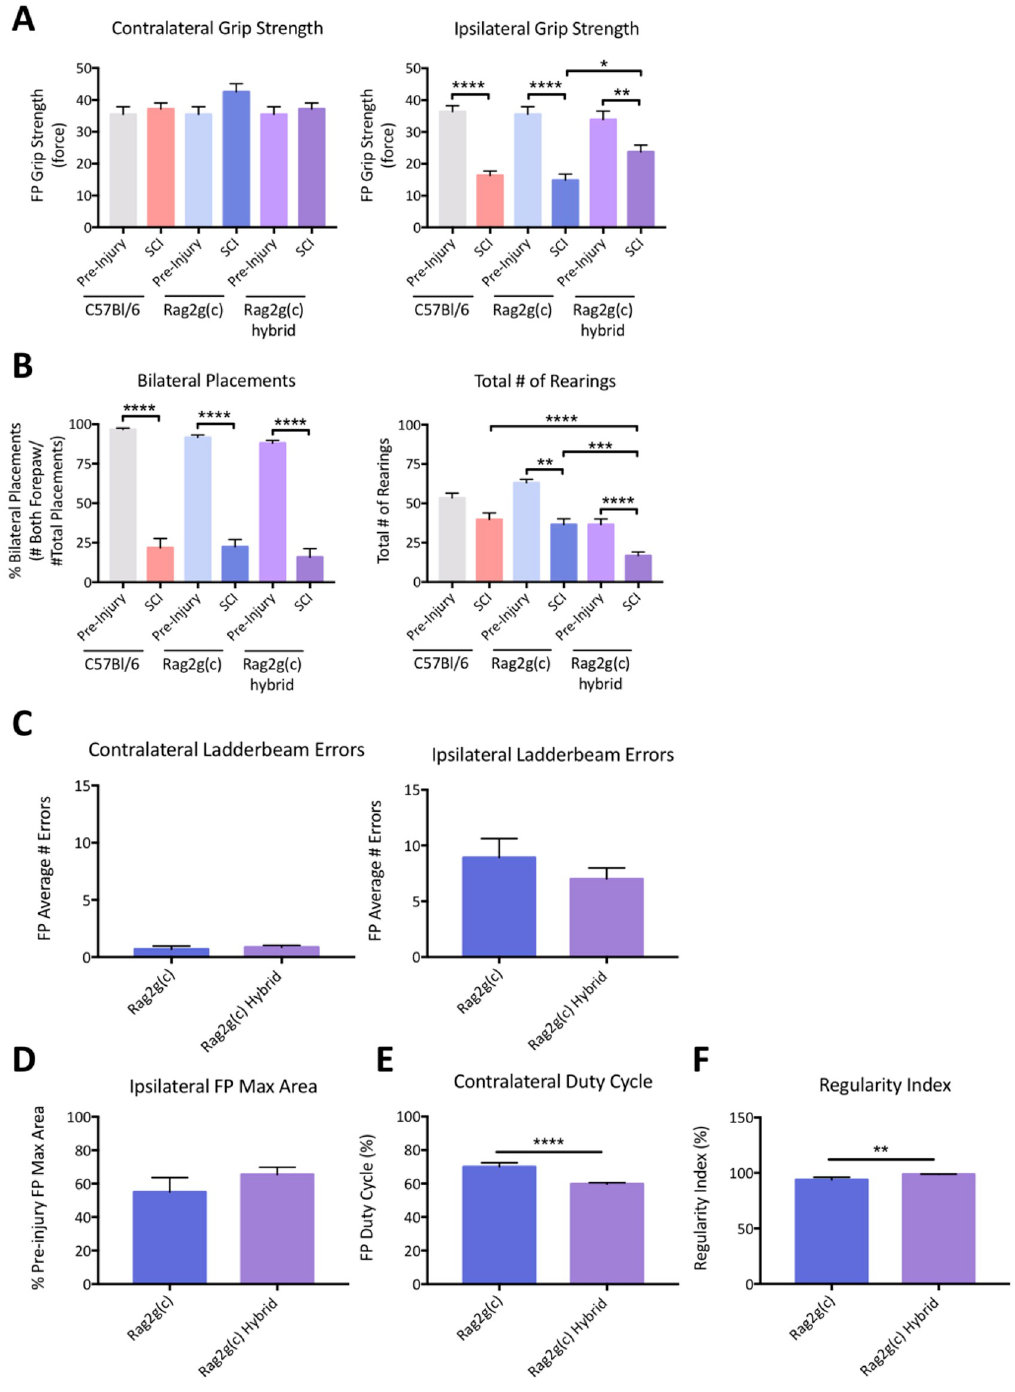
Fig 6. Standard C57BL/6 mice were compared at 8 weeks post-SCI with immunocompromised Rag2Gamma-/- (Rag2g(c)) as well as Agouti SCIDxRag2Gamma hybrid (Rag2g(c) hybrid) mice. While there was no difference in contralateral forepaw grip strength, the Rag2g hybrid mice had greater ipsilateral grip strength post-injury despite similar pre-injury values with Rag2g and C57BL/6 mice (A). The pre- and post-injury bilateral forepaw placements on the cylinder test were also similar between strains, although the Rag2g hybrid mice had a smaller total number of rearings pre- as well as post-injury (B). Data are expressed as mean ± SEM ( n = 11–12 per group). One-Way ANOVA with Tukey multiple comparisons, significance is only shown for pre- and post-injury comparison between each strain as well as post-injury values between strains; � , p � 0.05; �� , p � 0.01; ��� , p � 0.001; ���� , p � 0.0001. At 13 weeks post-injury, average contralateral and ipsilateral forepaw errors on